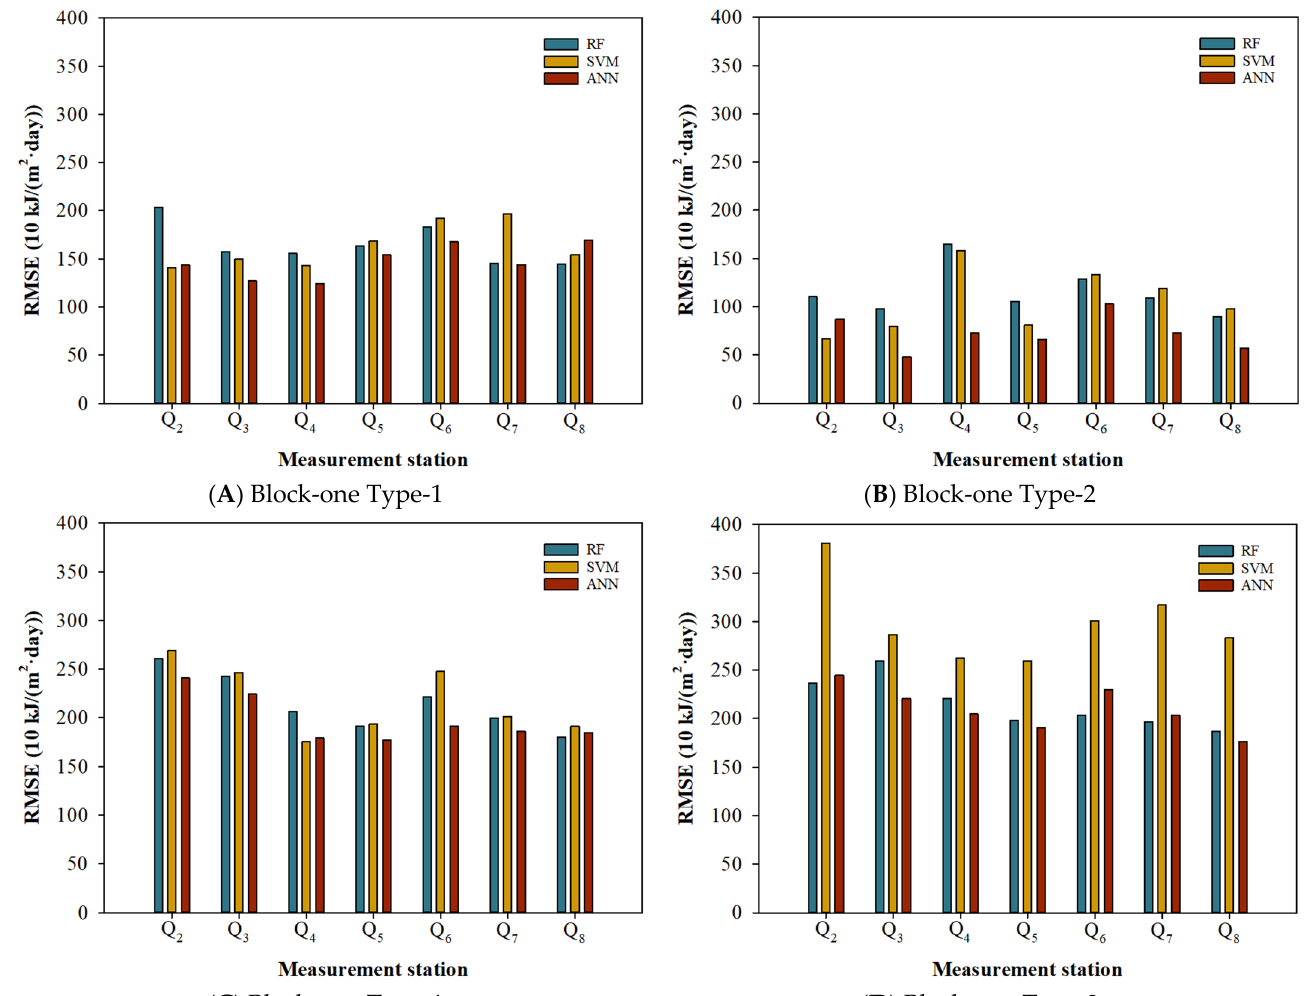
Figure 3. Root mean square error (RMSE) for each selected model based on the measurement station (Q 2 —Vigo-Campus (Vigo), Q 3 —Ponte Caldelas (Ponte Caldelas), Q 4 —Cabo Udra (Bueu), Q 5 —Sanxenxo (Sanxenxo), Q 6 —Porto de Vigo (Vigo), Q 7 —O Viso (Redondela), and Q 8 —Lourizán (Pontevedra)) and the combination of the variables (Block-one Type-1 ( A ) and Block-one Type-2 ( B )) and to predict MGSI one month ahead (Block-two Type-1 ( C ) and Block-two Type-2 ( D )). Data from Puga-Gil (2022) [31].